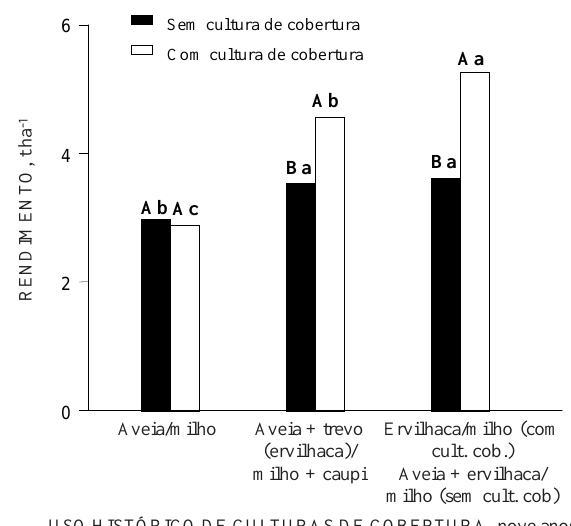
Figura 7. Rendimento de grãos de milho, consideran- do média de três sistemas de preparo. Letras maiúsculas comparam rendimento de milho em solo descoberto e coberto com resíduos dentro do mesmo sistema de cultura e letras minúsculas comparam sistemas de cultura dentro do sistema sem cultura de cobertura e com cultura de cobertura, pelo teste de Duncan a 5%.